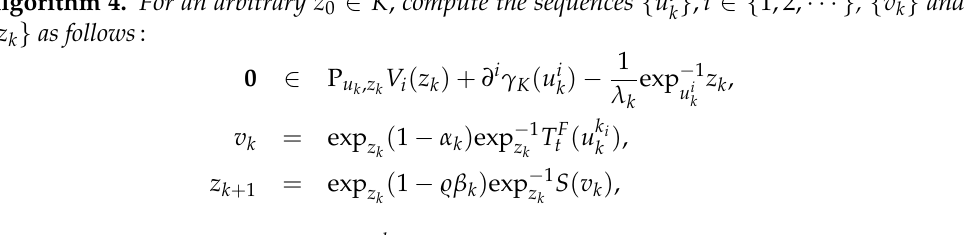
Algorithm 4. For an arbitrary z 0 ∈ K , compute the sequences { u i